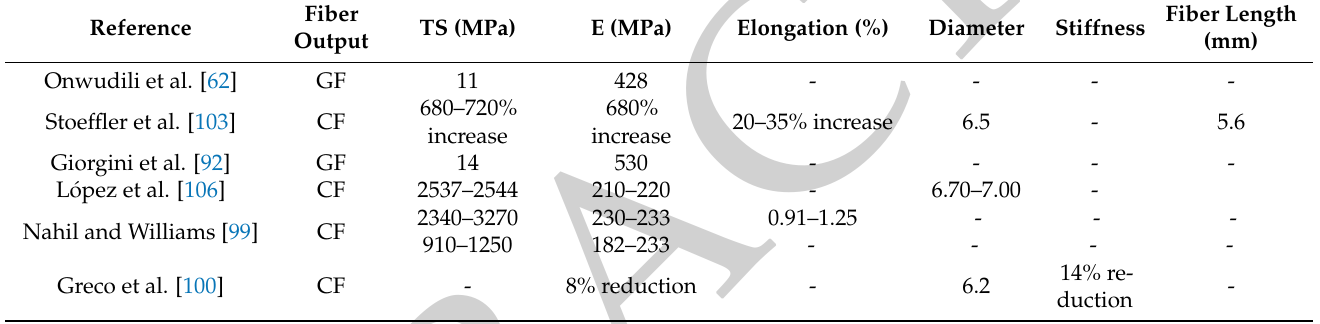
Table 3. Mechanical properties of rCF/rGF from pyrolysis of